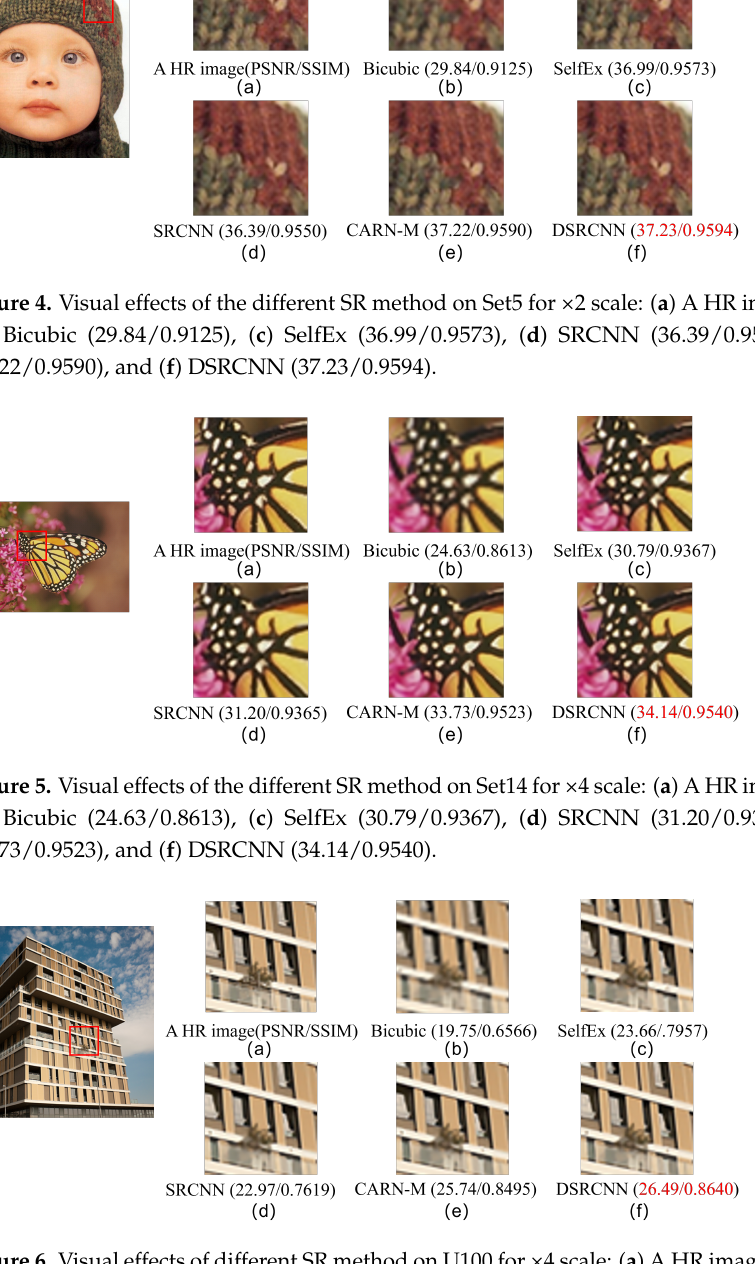
Figure 6. Visual effects of different SR method on U100 for ×4 scale: ( a ) A HR image (PSNR/SSIM), ( b ) Bicubic (19.75/0.6566), ( c ) SelfEx (23.66/.7957), ( d ) SRCNN (22.97/0.7619), ( e ) CARN-M(25.74/0.8495), and ( f ) DSRCNN